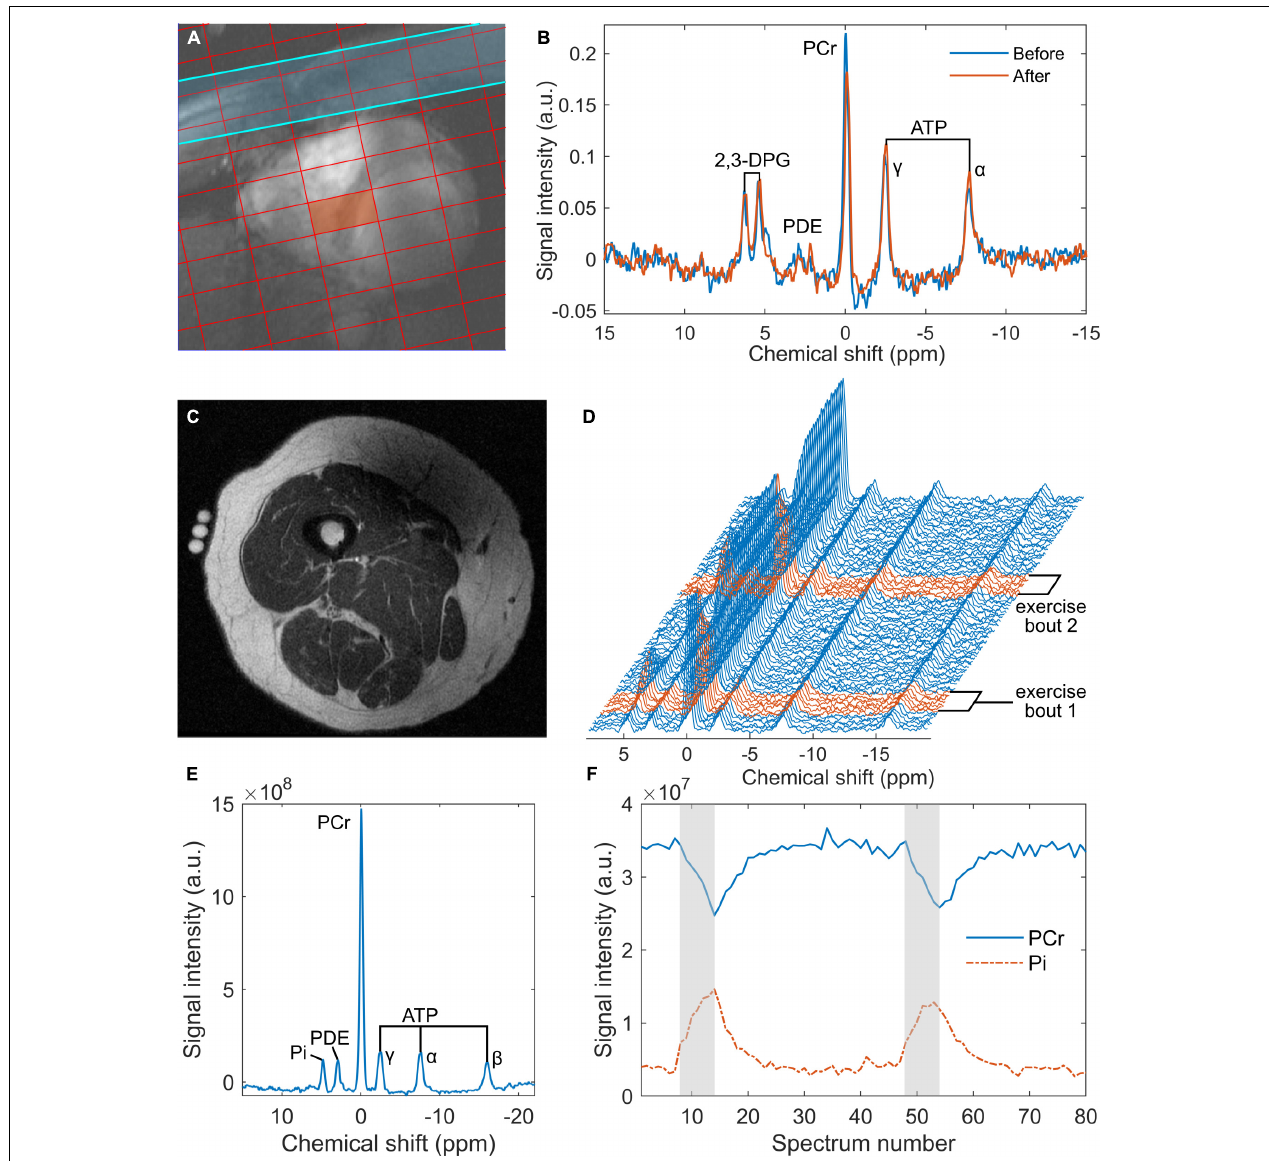
FIGURE 1 | Representative data from the 7 tesla 31 P cardiac magnetic resonance spectroscopy (MRS) acquisition (A,B) and the 3 tesla skeletal muscle acquisition (C–F) : (A) an example of localisation showing a chemical shift imaging grid superimposed on a short-axis, spoiled gradient-recalled echo cine image of the heart, where the red rectangle denotes the voxel of interest and the blue strip represents a saturation band used to suppress signal from skeletal muscle; (B) cardiac 31 P spectra obtained from the septal voxel shown in a, pre- and post-intervention (‘Before’ and ‘After’, respectively); (C) an inversion recovery fast spin echo localiser image of a participant’s right thigh, showing fiducials at the centre of the 15 cm 31 P coil positioned over the vastus lateralis; (D) a series of 80 31 P spectra averaged in groups of 3 from the 240 spectra acquired during rest and exercise—exercise spectra are highlighted in red; (E) an average rest spectrum obtained during the one-minute rest period at the beginning of the 31 P-MRS acquisition; and (F) time courses of phosphocreatine (PCr) and inorganic phosphate (Pi) derived from peak fitting of the dynamic spectra from panel (D) , with exercise periods indicated in grey. ATP, adenosine triphosphate; a.u., arbitrary units; 2,3-DPG, 2,3-diphosphoglyceric acid; PCr, phosphocreatine; PDE,